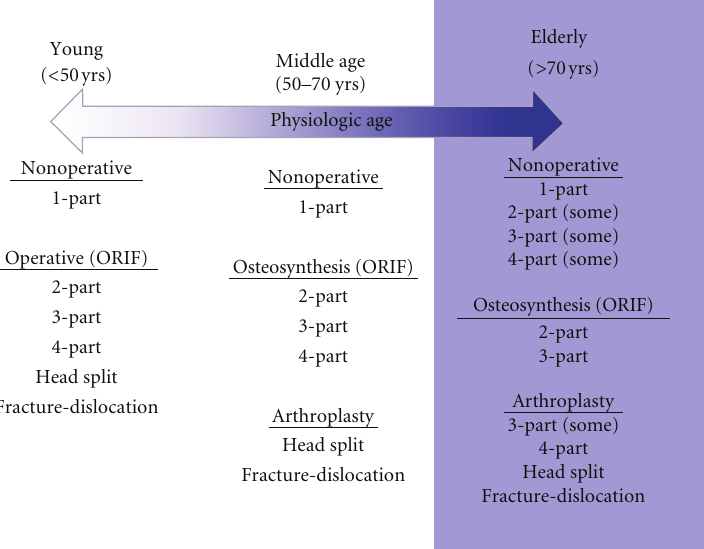
Figure 6: Treatment algorithm for proximal humerus is based on patients chronological and physiological age. Young patients are treated more aggressively with osteosynthesis making every attempt to restore normal anatomy, while the older patient may benefit from an array of treatments ranging from nonoperative to prosthetic